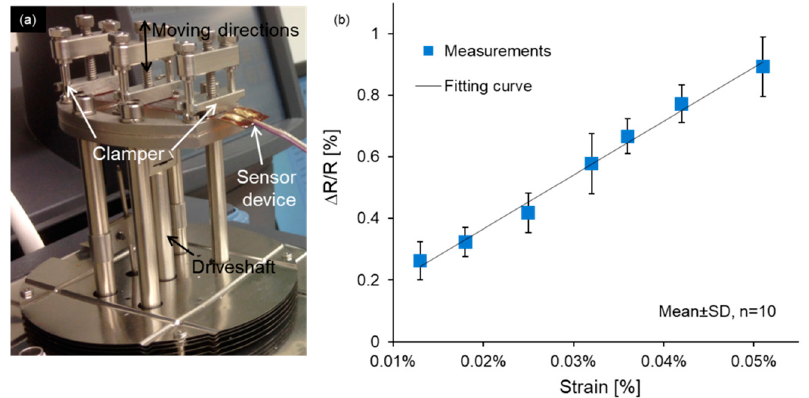
Figure 6. Experimental measurements use ( a ) dual cantilever mode of the DMA and ( b ) show the relationship between the Δ R/R and bending strain in the stretching process .